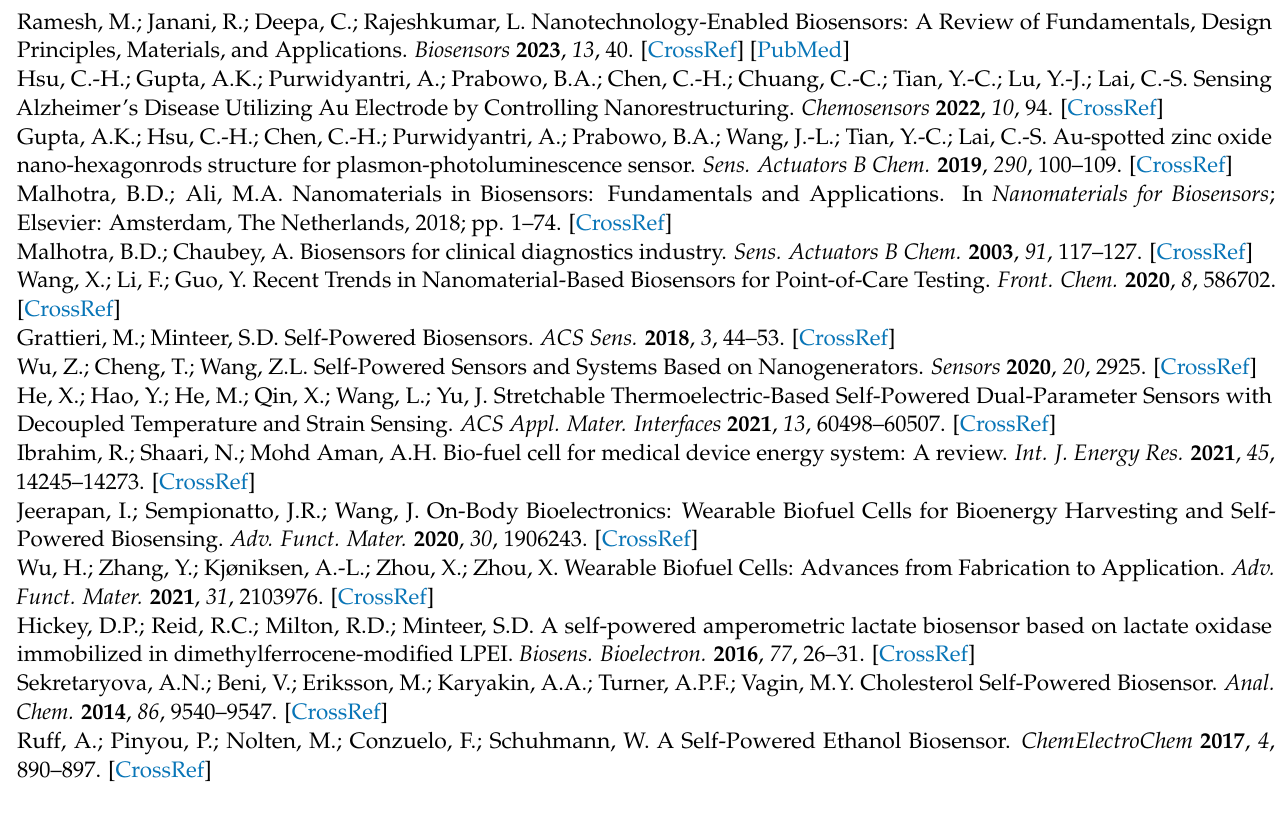
probing performance of the optical readout; Figure S2: Open circuit potential (OCP) dependence on glucose concentration. Figure S3: Enlarged section of the power density vs Cglucose plot in the range of concentrations between 0 and 1 mM (highlighted in blue in Figure